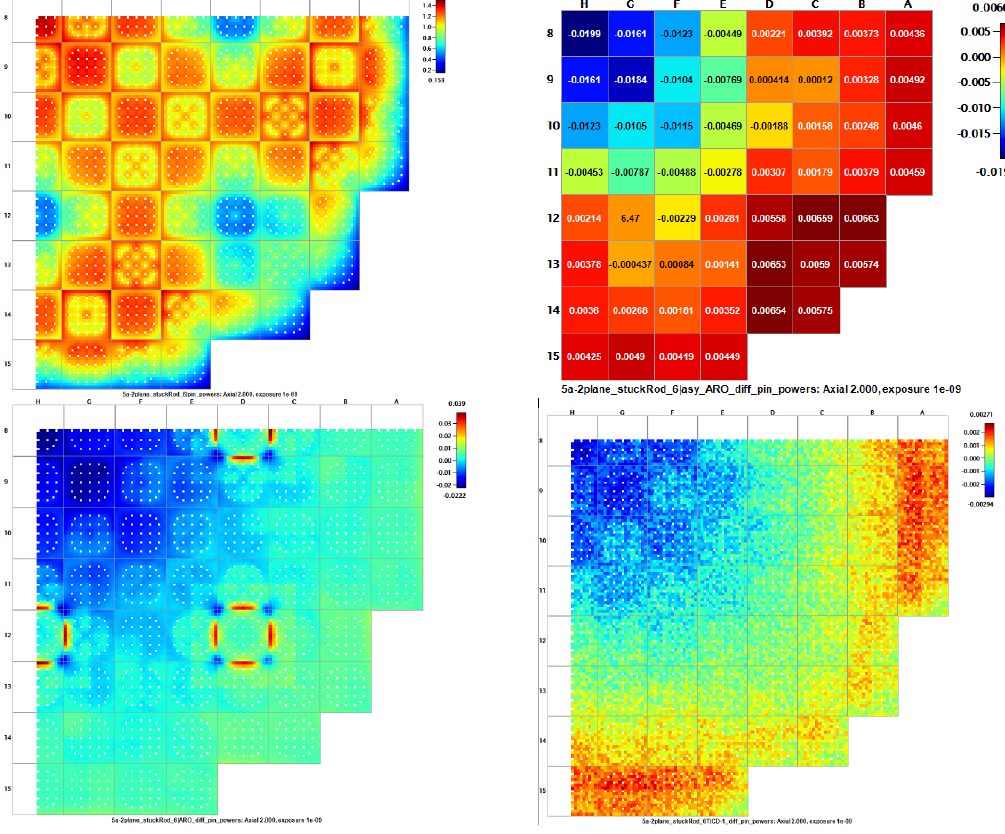
Figure 1. Case 10 CD-1 VERA pin power distribution (upper left) and NESTLE – VERA assembly power differences (upper right) using VERA ARO unrodded nodal parameters state points, and NESTLE - VERA pin power distribution generated using VERA ARO unrodded nodal parameters (bottom left) and VERA CD-1 (bottom right) state points [note scale change for these two